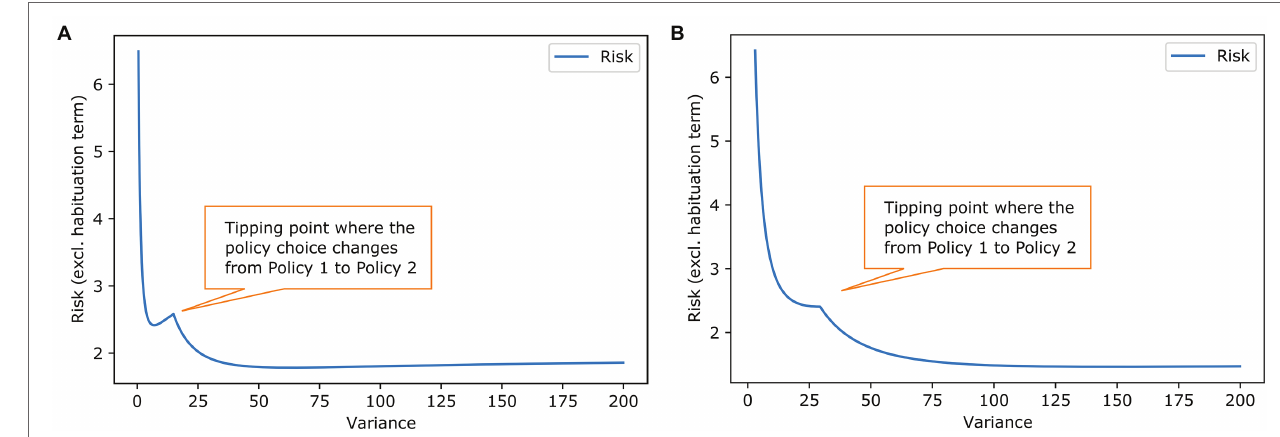
FIGURE 4 | Social acceptance scenario-effect of goal prior variance and habituation tendency on risk. The plotted lines work analogously to the lines in Figure 2 in the example of work stimulus. (A) The blue line shows again the influence of the prior shape. The tipping point for choosing another policy has slightly different shape but results in the same conclusion as in Figure 2 that a habituating agent will change its policy choice. (B) The liens are anologue to Figure 2B . Here, a habituation tendency above roughly 0.03 results in stress habituation of the